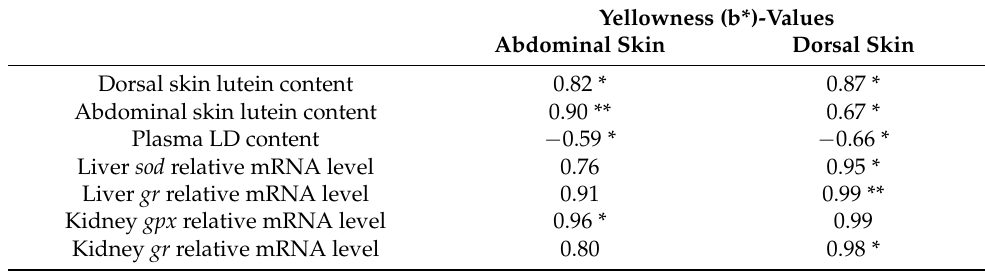
Table 4. Correlation coefficients (r) between yellow catfish skin yellowness (b*-values) and skin lutein and oxidative stress